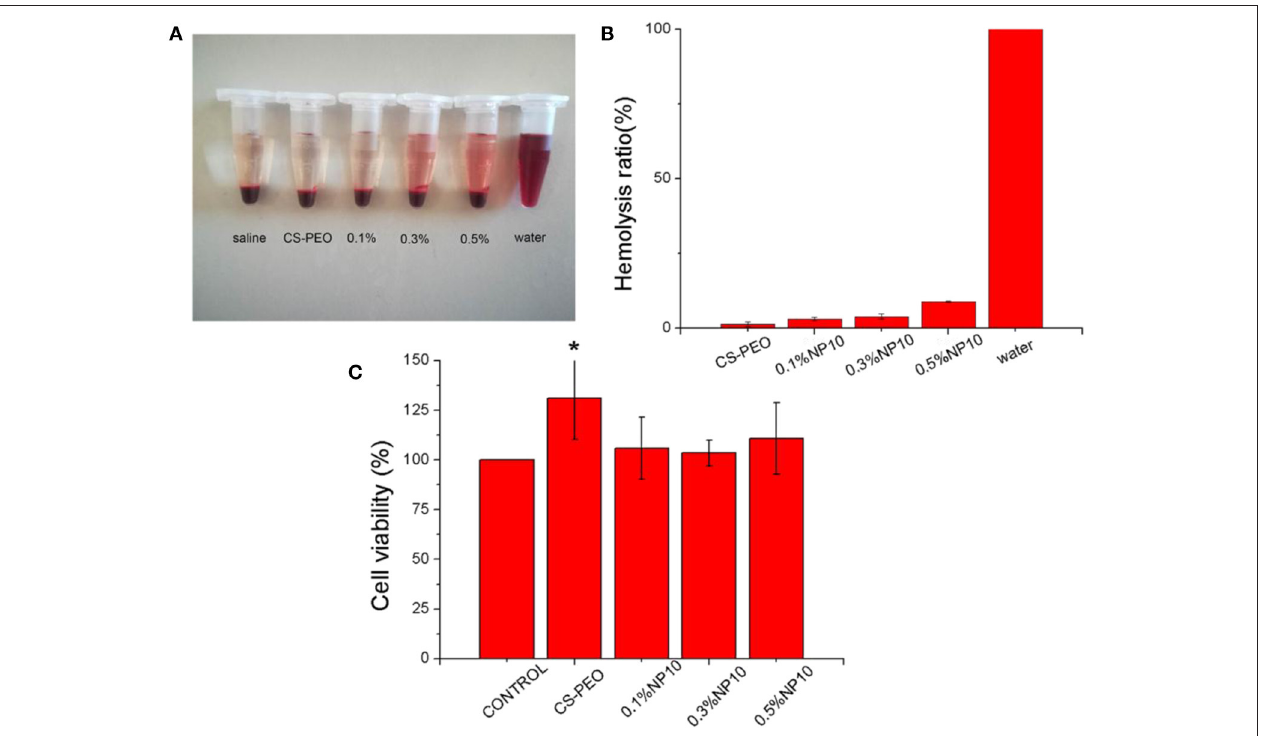
FIGURE 4 | (A) Photographs of fresh human blood incubated with different concentrations of CS-PEO-NP10. (B) Hemolysis ratio of different concentrations of CS-PEO-NP10. (C) MTT assays of CS-PEO-NP10 nanofibers with different amounts of NP10. The data represented mean and standard deviations of the 6 samples. Compared with the control group, * P =